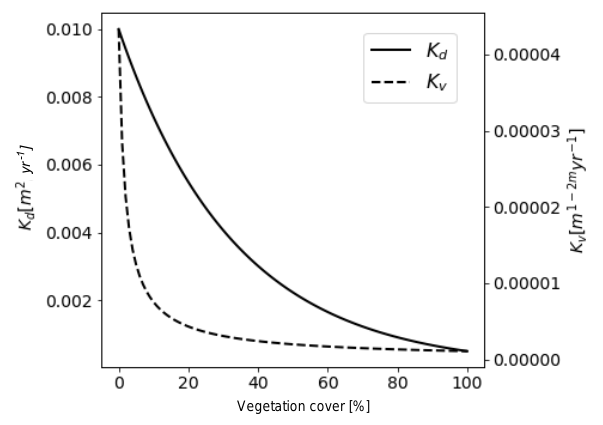
Figure 6. Predicted values of hillslope diffusivity ( K d ) (solid line) and fluvial erodibility ( K v ) (dashed line) as a function of vegetation surface cover. Although absolute values can not be compared due to different units, the shape of the curves representing the different pa- rameters show different sensitivities to changes in vegetation cover. Major sources of the nonlinearities are discussed in the text. Fluvial erodibility shows the highest magnitude of change for vegetation cover values < 25%, whereas hillslope diffusivity reacts in a more linearly fashion with the highest change observed below < 65% vegetation